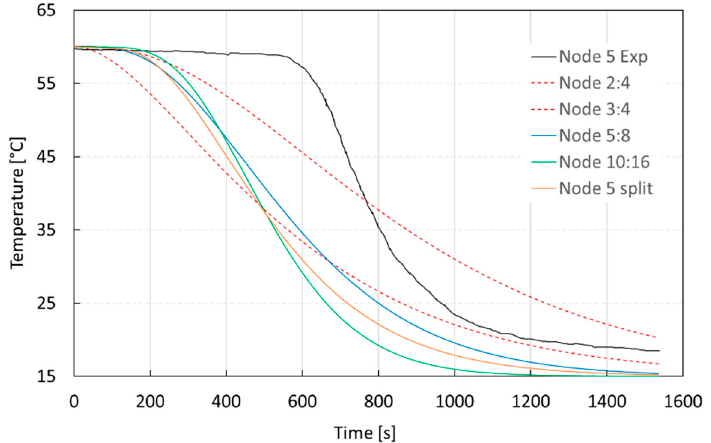
Figure 20. Experimental temperature evolution at node #5 vs. simulation results—5 dm 3 /min volume flow rate—discharge phase.